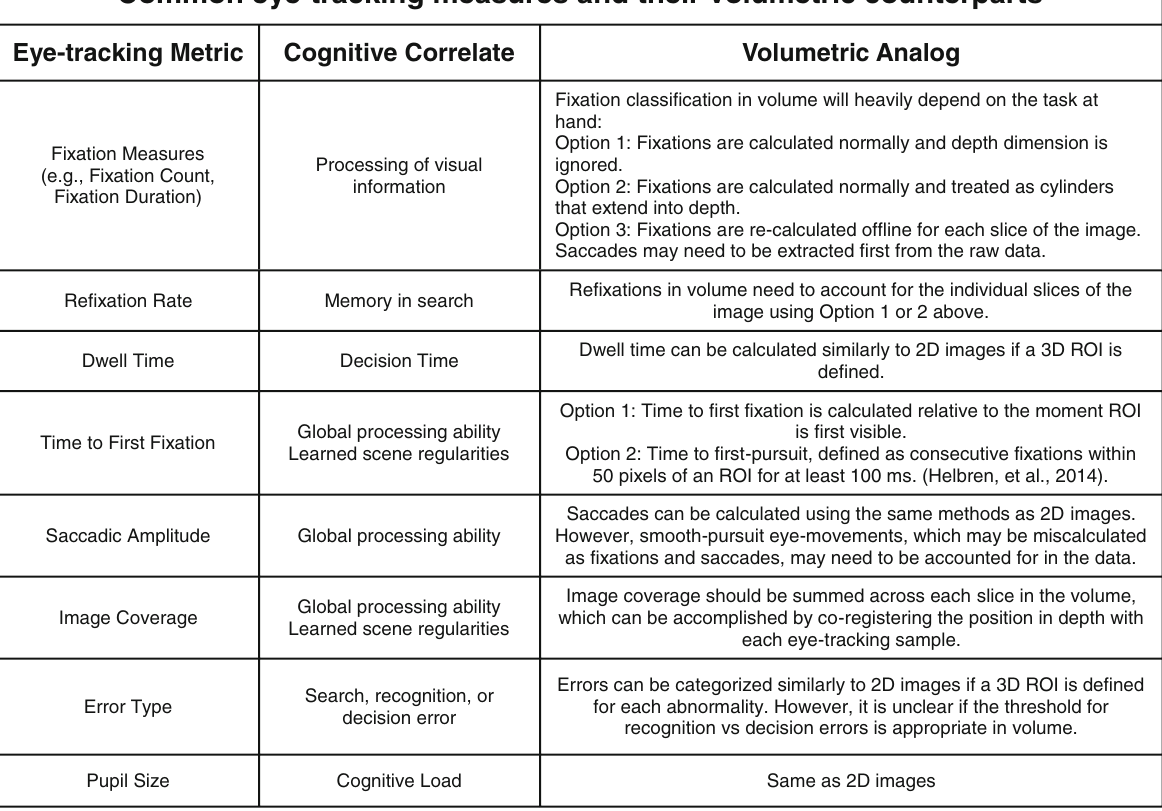
Table 3 Common eye-tracking metrics, their cognitive correlates, and proposed analogs for volumetric medical images. ROI, region of